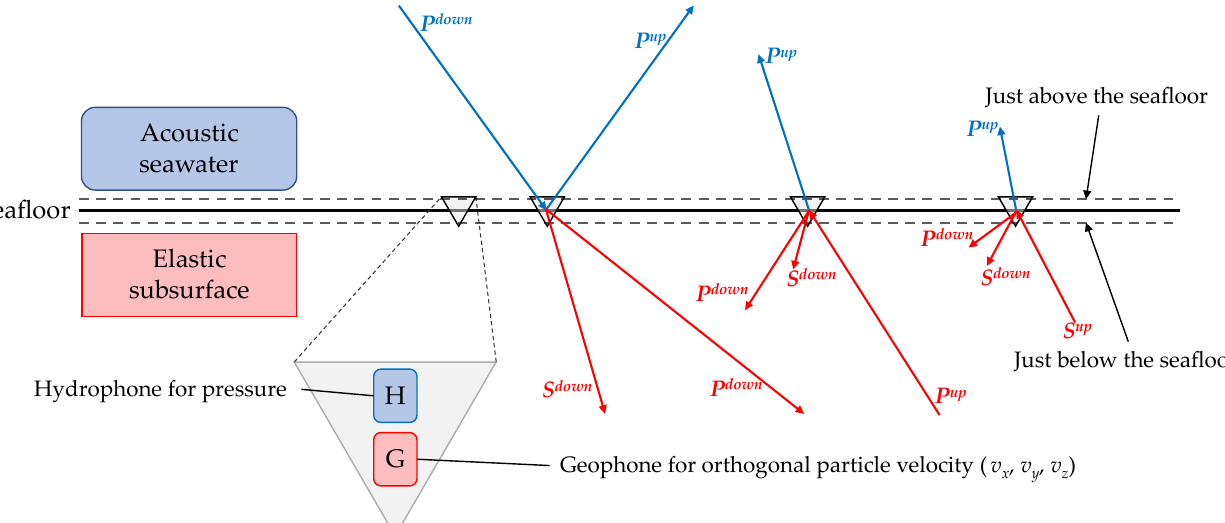
Figure 1. Schematic diagram of ocean-bottom multicomponent seismic data acquisition. Triangles represent ocean-bottom receivers. Waves received by seawater-coupled hydrophones are marked blue while waves received by seabed-coupled geophones are marked red. Ocean-bottom refractions that propagate horizontally are neglected in this figure for clarity. The black horizontal line denotes the fluid–solid interface. The horizontal dashed lines above and below the seafloor line respectively denote the depth level of acoustic decomposition and the depth level of elastic decomposition.